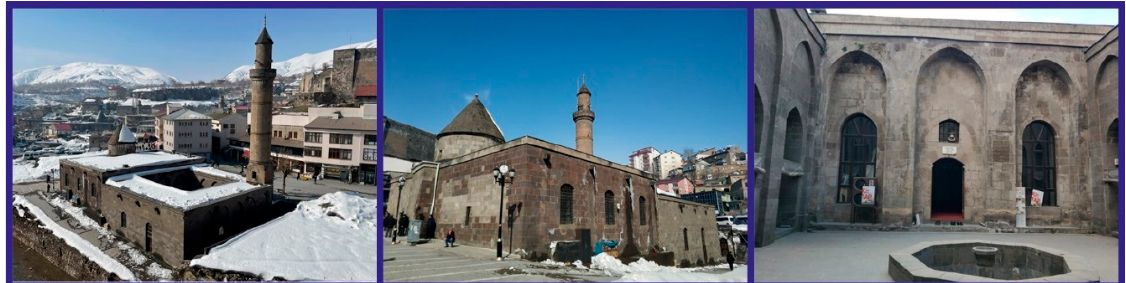
Figure 2. The Ulu (Grand) Mosque and its minaret.